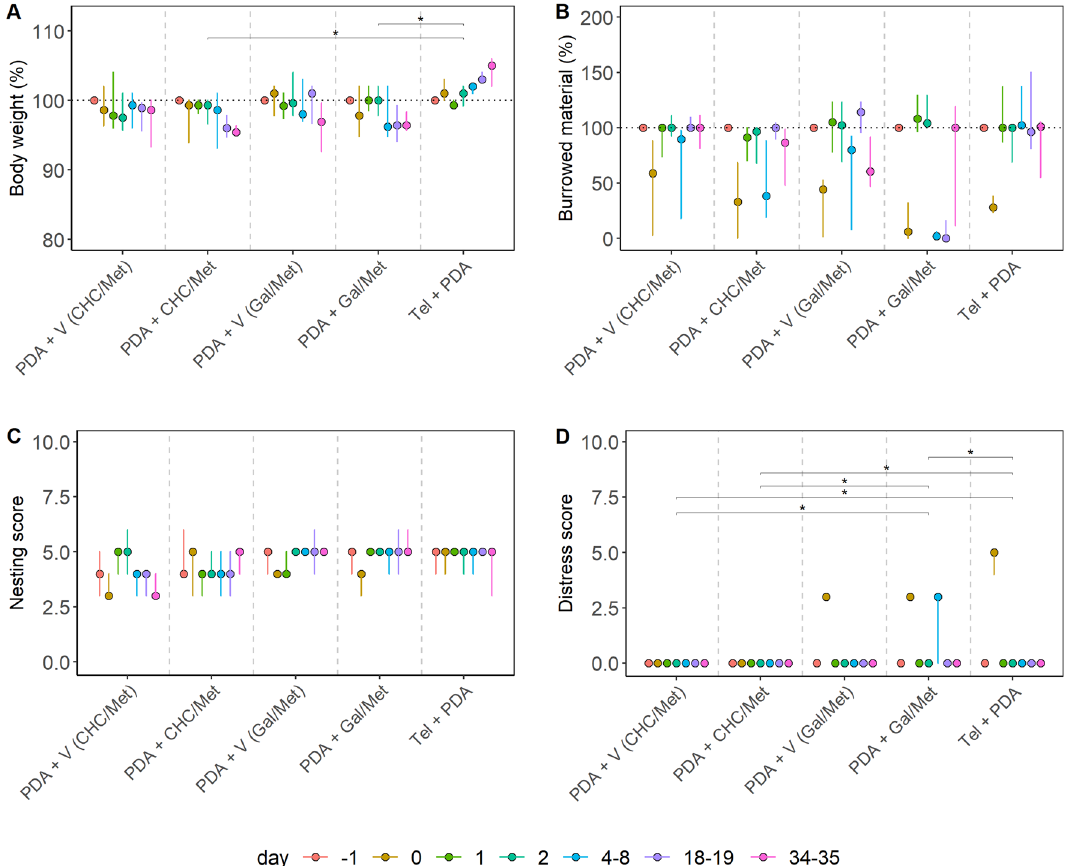
Figure 1. Distress evaluation of an orthotopic pancreatic cancer model. Pancreatic cancer (PDA) was treated with α-cyano-4-hydroxycinnamate plus metformin (CHC/Met), Galloflavin plus Metformin (Gal/Met), or the respective vehicle solutions (V). Telemetric transmitters were implanted into mice in a separate experiment, and 6606PDA cells were injected into the pancreas (Tel + PDA). The percentage of body weight ( A ), the percentage of burrowing activity ( B ), nesting ( C ), and the distress score ( D ) were evaluated on the indicated days. Differences between the groups in ( A ) were assessed with the Kruskal–Wallis test. Significant differences in body weight between the groups were detected ( χ 2 = 44.871, df = 4, p < 0.0001), and the following post hoc comparisons revealed differences between the groups PDA + CHC/Met and Tel + PDA (*p adj = 0.035) as well as between PDA + Gal/Met and Tel + PDA (*p adj = 0.035). Group differences were also present in the distress score ( χ 2 = 12.67, df = 4, p = 0.013), between PDA + V (CHC/Met) and PDA and Gal/Met (*p adj = 0.015), PDA + V (CHC/Met) and Tel + PDA (*p adj = 0.031), PDA + CHC/Met and PDA + Gal/Met (*p adj = 0.015), PDA + CHC/Met and Tel + PDA